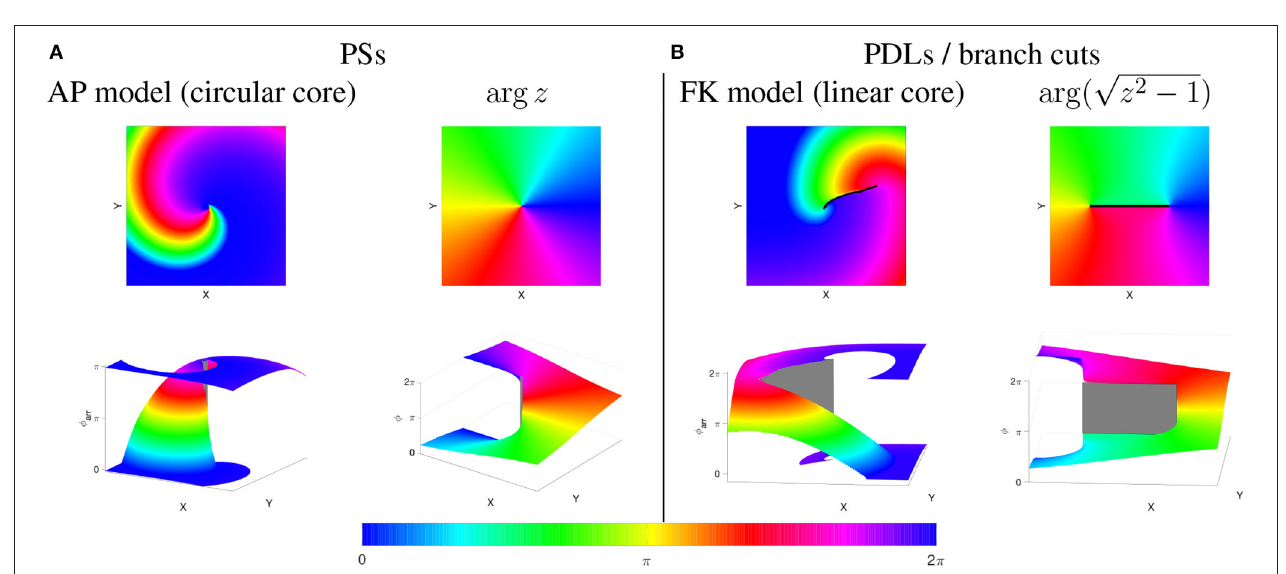
FIGURE 8 | PSs vs. PDLs in cardiac models and complex analysis. Phases are rendered in-plane (top row) and in 3D, as a Riemannian surface (bottom row). (A) Rigidly rotating spirals, as in the Aliev-Panfilov (AP) reaction-diffusion model (Aliev and Panfilov, 1996) correspond to a PS (gray), similar to the mathematical function φ ( x , y ) arg( z ) shown to the right of it. (B) Linear-core cardiac models, e.g., (Fenton and Karma, 1998) exhibit a PDL or branch cut (black/gray), like the mathematical = f ( z ) function w arg( √ z 2 1) shown to the right of it. Gray areas denote a jump in the phase over a quantity not equal to an integer multiple of 2 π , i.e., a PDL = = − (physics) or branch cut